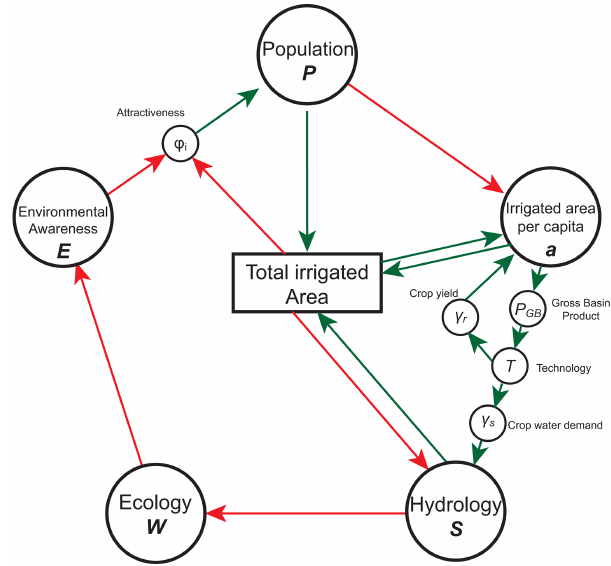
Figure 4. Conceptual framework coupling the five subsystems (hy- drology, population, irrigation, ecology and environmental aware- ness) and the cross-system feedbacks. Green: positive feedback; red: negative